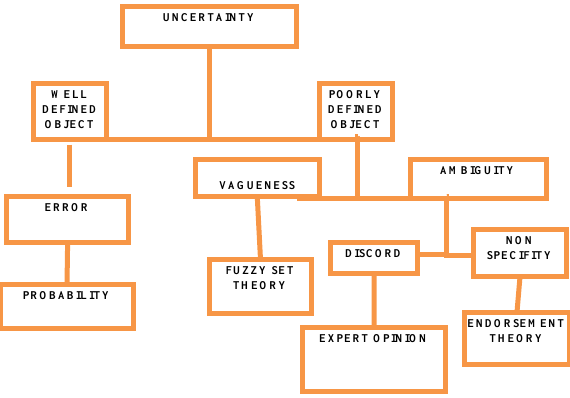
Figure1. The conceptual model of uncertainty in spatial